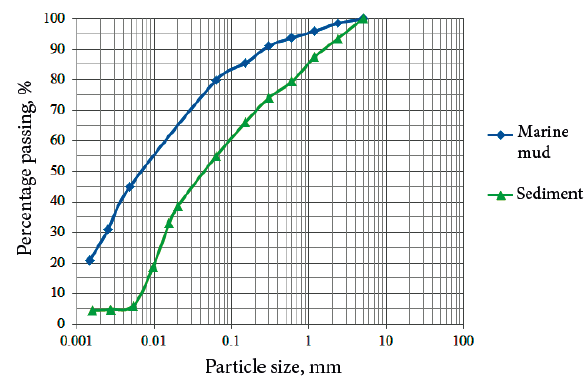
Fig. 1. Particle size distribution of contaminated marine mud and